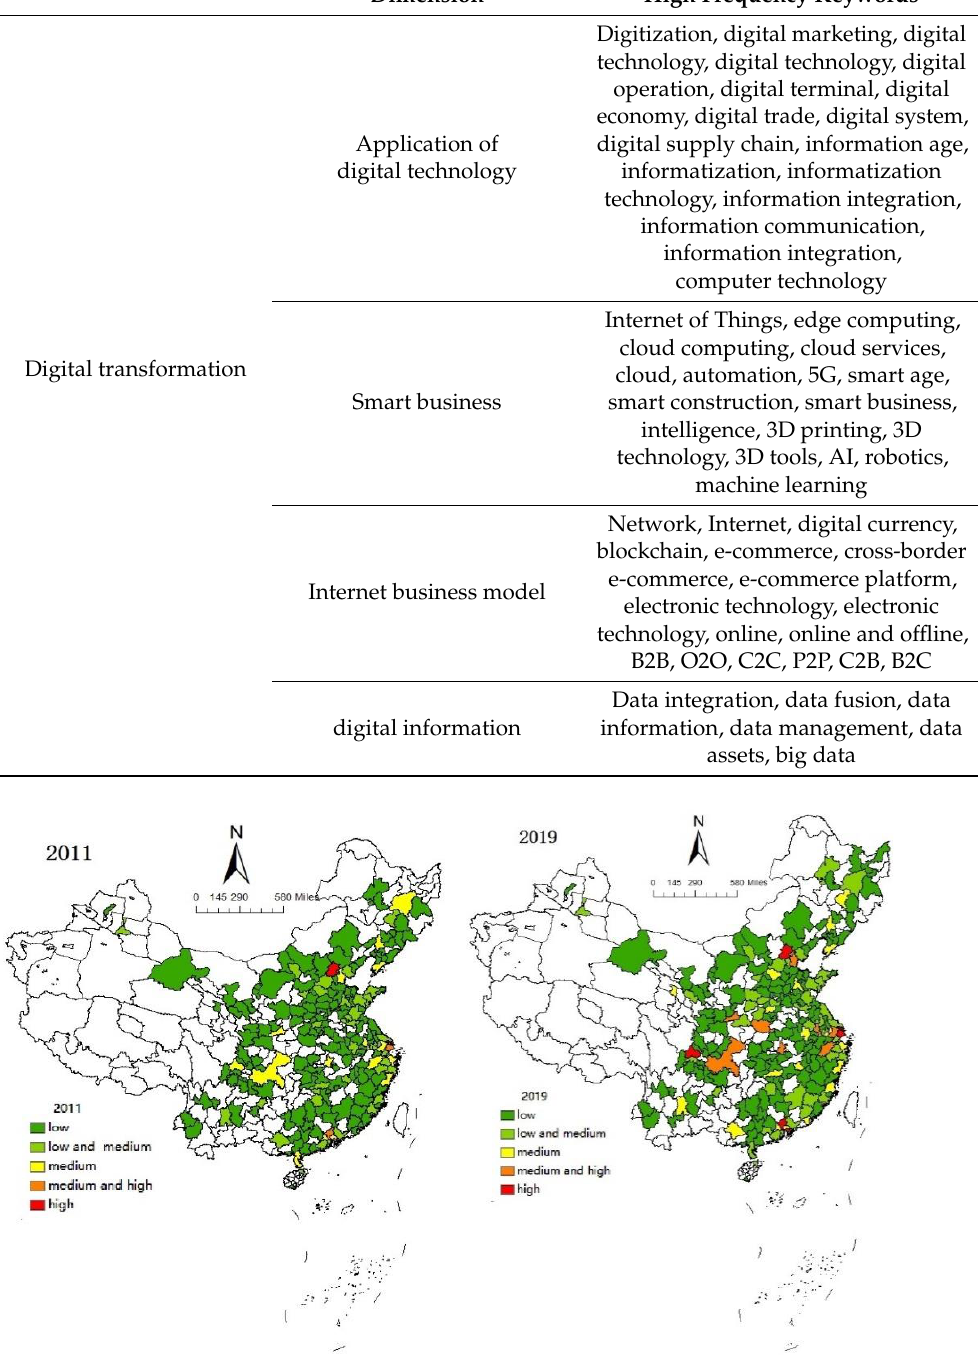
Figure 1. Trends in agricultural digital Transformation from 2011 to 2019.